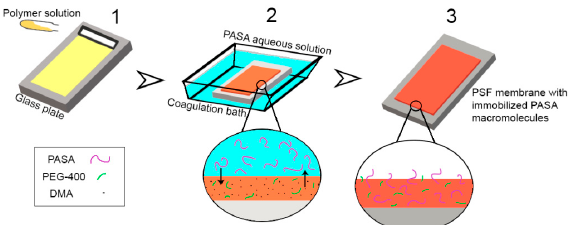
Figure 2. Schematic representation of the formation of polysulfone (PSF) flat-sheet membranes via NIPS using PASA aqueous solution as a coagulation bath: ( 1 )—casting of the PSF solution on the glass plate using doctor blade; ( 2 )—immersion of the cast polymer film in the coagulation bath, membrane structure is formed due to the solvent-non-solvent exchange (PEG and DMA di ff use out of the polymer film and PASA aqueous solution di ff uses into the polymer film); ( 3 )—PSF membrane with immobilized PASA macromolecules is